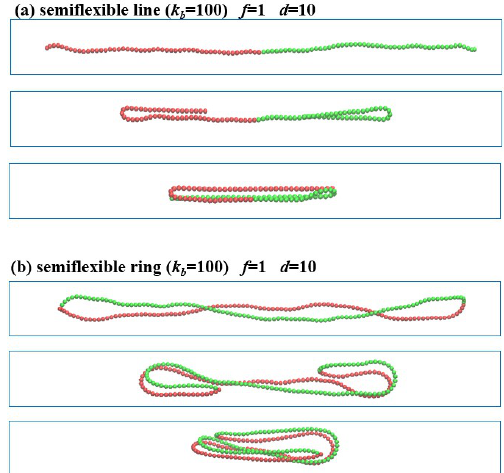
Figure 4. Compression of semiflexible polymers in the confined channel with d = 10 under the com- pression force ( f / k B T = 1.0). ( a ) Linear polymer with the end-to-end distance L x = 97.5,57.4,31.1 (from top to bottom). ( b ) Ring polymer with L x =